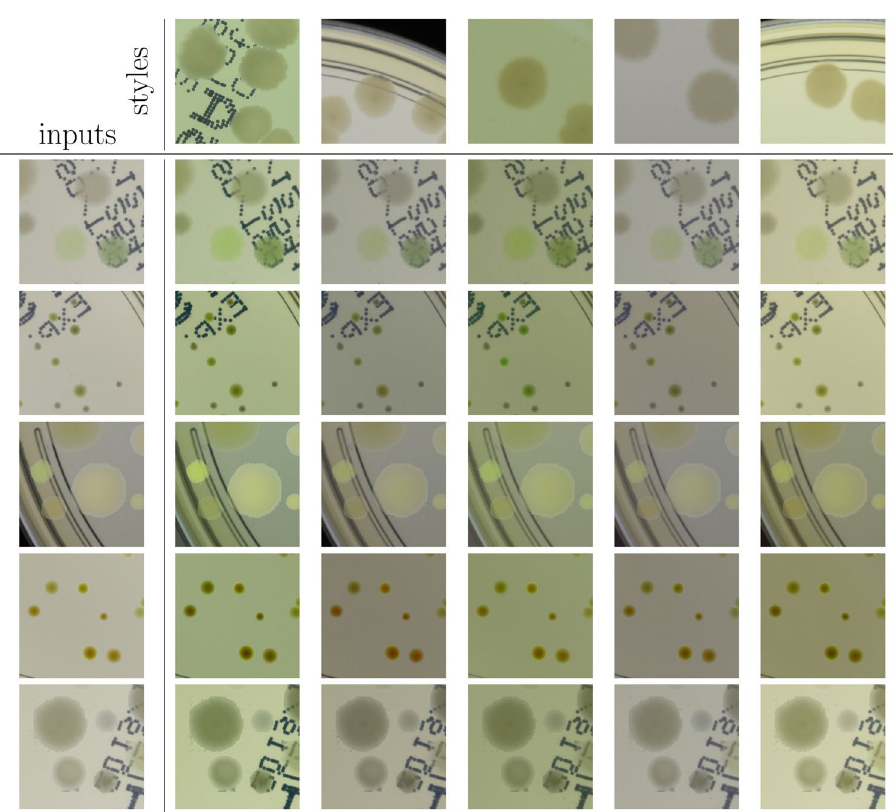
Figure 6. Stylization of generated microbial data. Five synthetic patches (left) are stylized (with (cid:31) = 0.05 ) using the style of five real images (top). Stylization improves realism of the generated images and significantly increases performance of a deep learning detector trained on this